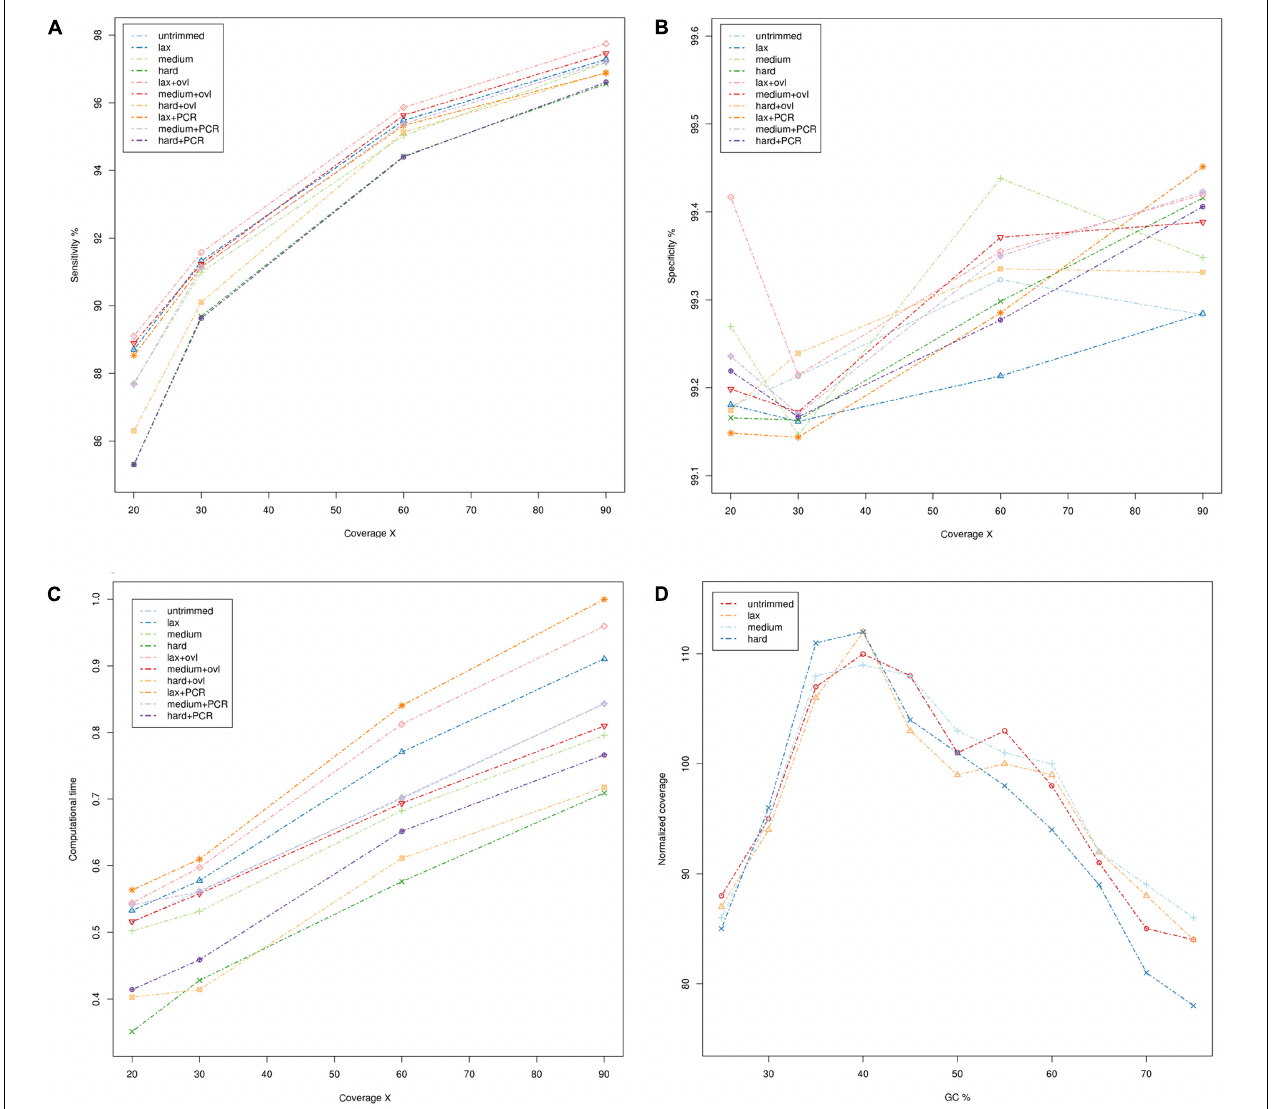
FIGURE 1 | Comparison of quality assessment pipelines on Whole Genome Sequencing data. (A) Sensitivity of quality assessment pipelines at different levels of coverage. (B) Specificity of quality assessment pipelines at different levels of coverage. (C) Computation time required by the pipelines. Times reported have been scaled with unity-based normalization. (D) Normalized coverage levels with respect to GC composition. Coverage levels and GC composition were calculated on genomic windows of 200 bp, overlapping by 100 bp. Coverage levels were normalized using the upper-quartile normalization and scaled to 100 (where 100 represents the expected